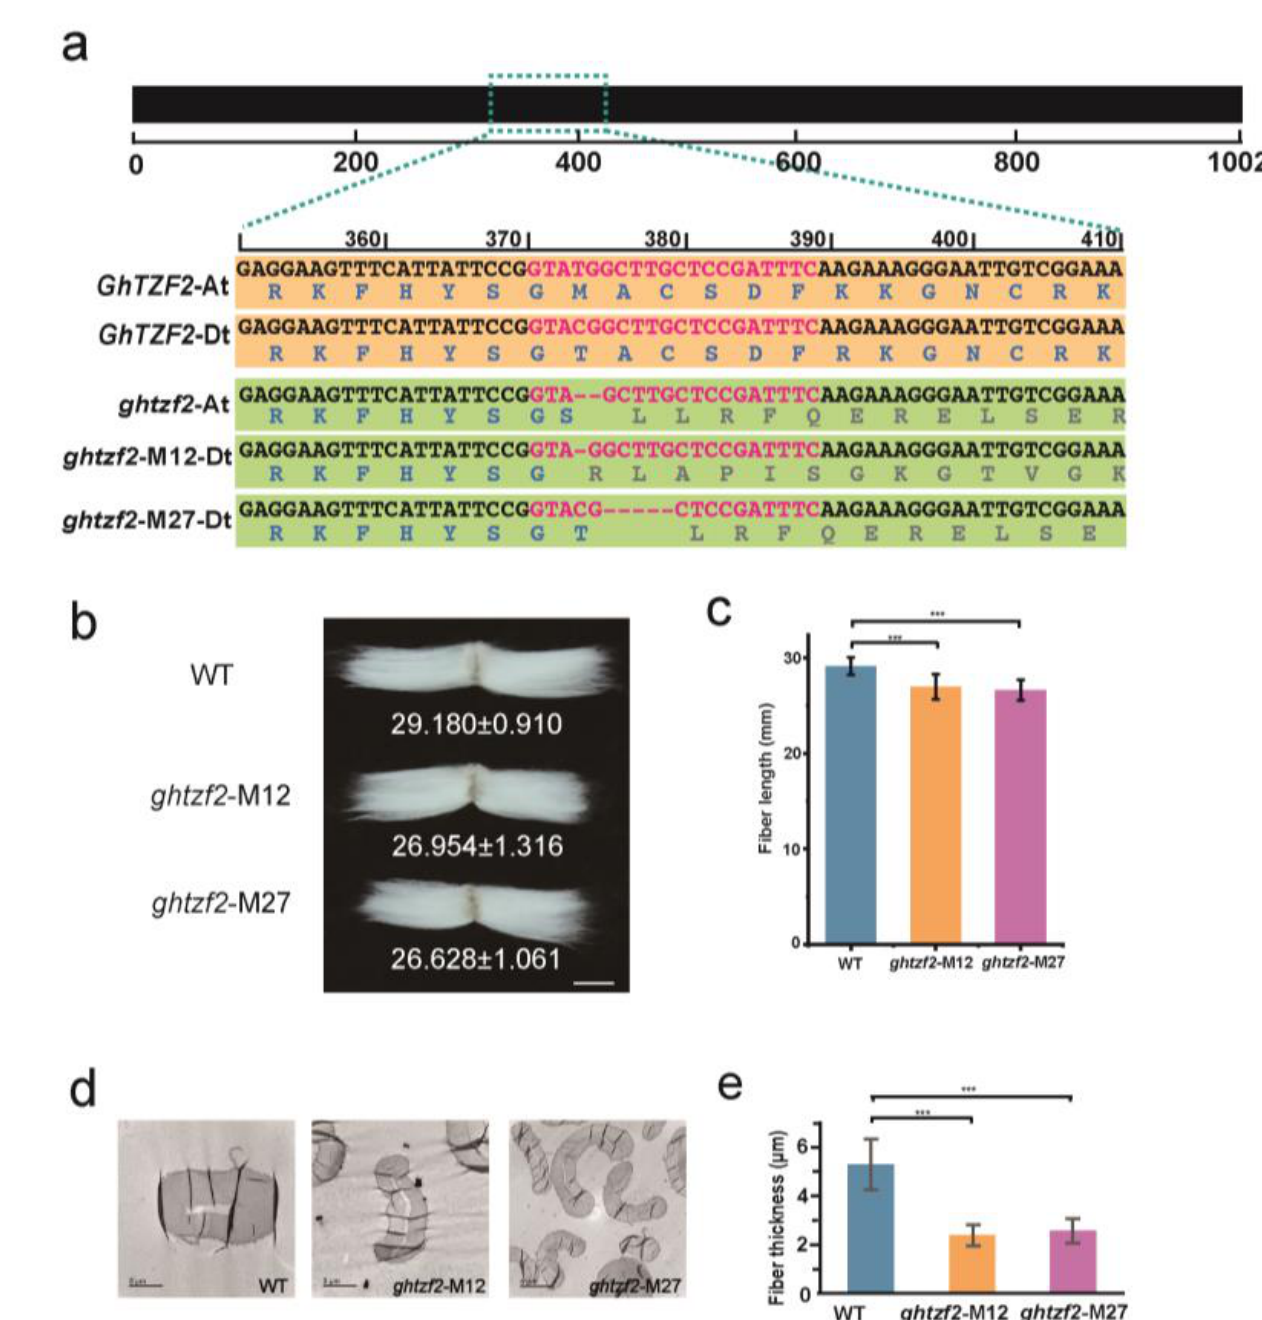
Figure 4. Sequence mutations and morphological alterations in GhTZF2 -knockout lines. ( a ) Sequence identification of both sub-genome At and sub-genome Dt in ghtzf2 -M12, ghtzf2 -M27, and WT. In every colored box, the upper line shows the DNA sequence and the lower line shows the amino acid sequence. In both two knockout lines, the base deletions introduce frameshift mutation leading to a premature stop codon. ( b , c ) Comparison of fiber length among WT, ghtzf2 -M12, and ghtzf2 -M27. The results were calculated with 60 samples each. Error bars indicate ± SD. *** p < 0.001. ( d , e ) Comparison of mature fiber cell wall thickness of WT, ghtzf2 -M12, and ghtzf2 -M27. Samples were observed under TEM. The results were calculated with 60 samples each. Error bars indicate ±SD. *** p < 0.001.